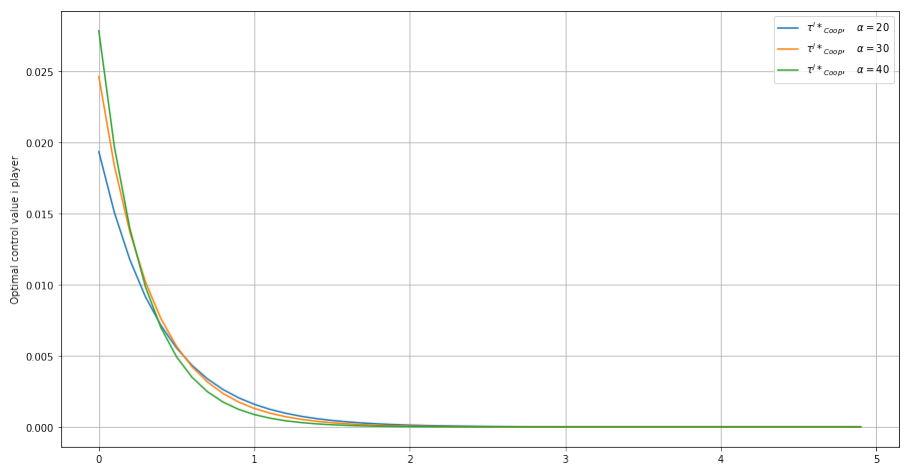
Figure 8. The optimal controls of player i under cooperative scenario and different α .